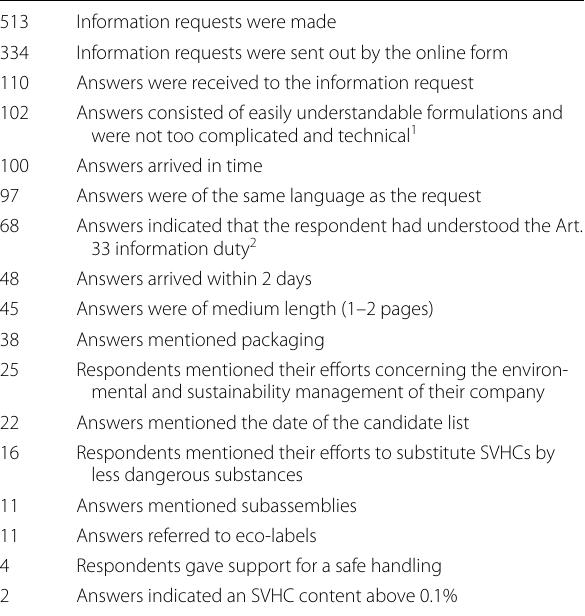
Table 3 Results of Art. 33(2) information requests on SVHCs in a targeted choice of